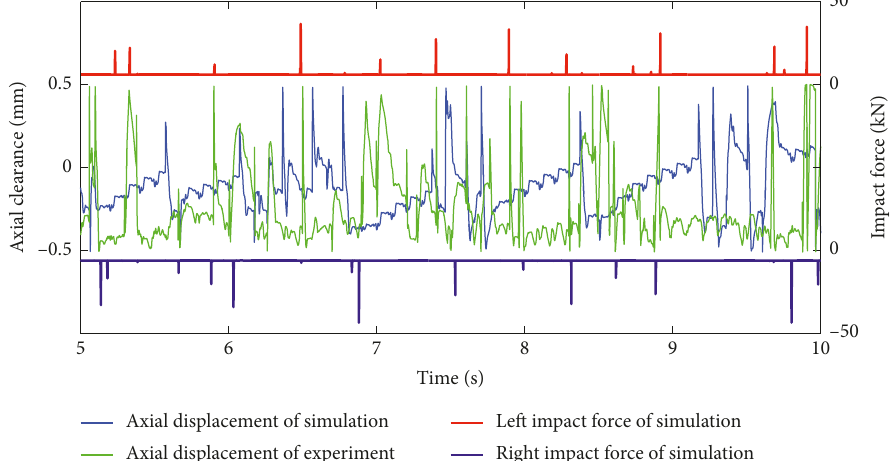
Figure 21: Displacements and contact forces between journal flanges and bearing bases in the axial direction during simulation with c and c r � 0.5.